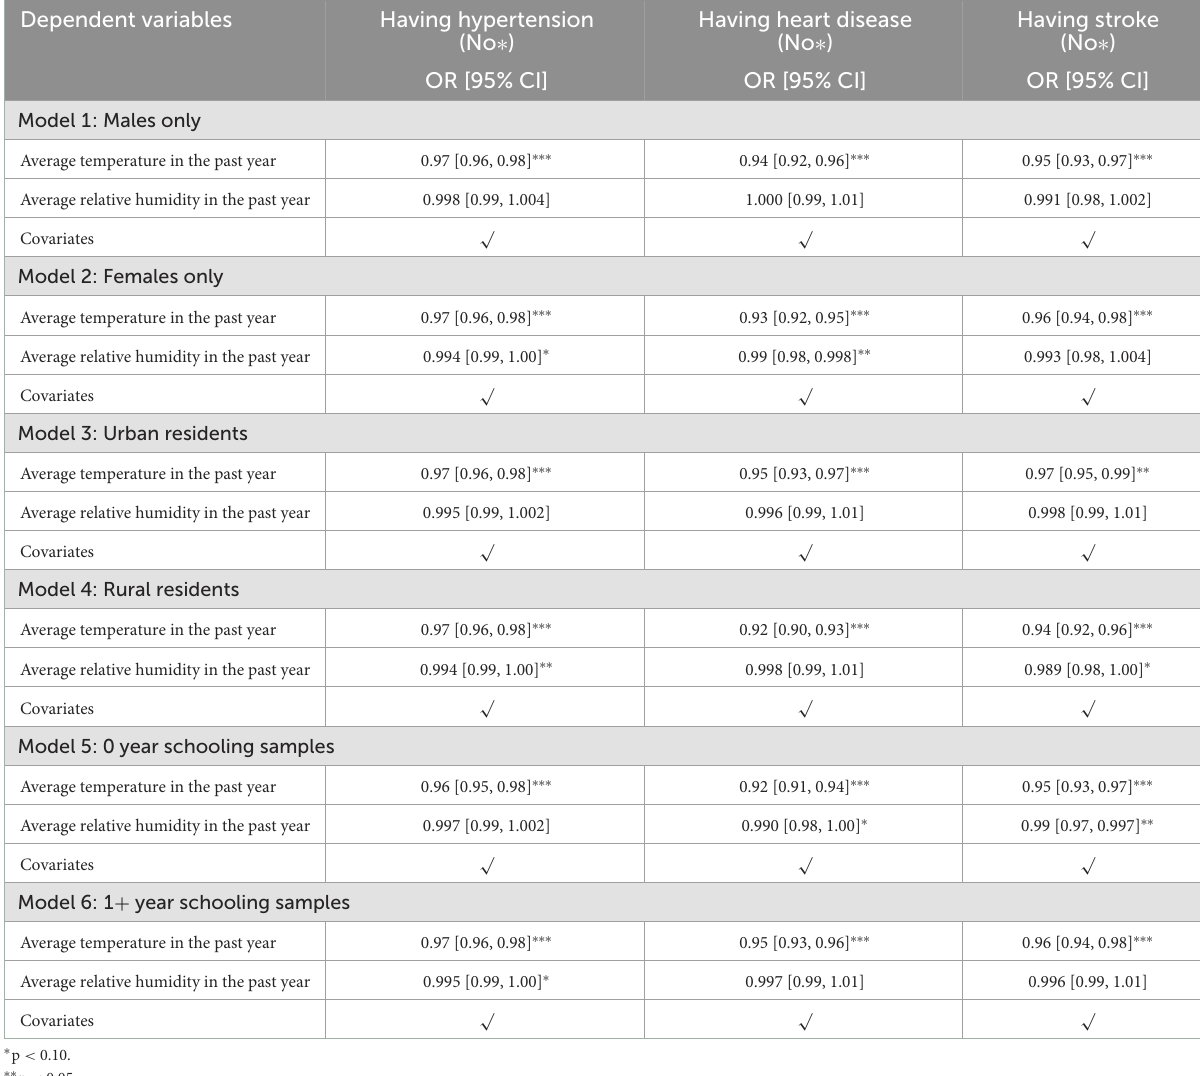
TABLE 3 Effects of temperature and relative humidity and on CVD during 2002–2018, by subgroups models. Dependent